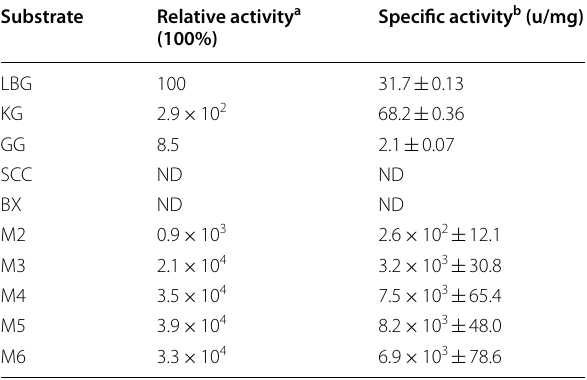
ND not detected a The relative activity of PcMan113 towards LBG was set as 100% b The specific activity of substrates by PcMan113 catalyzing in vitro. Reaction conditions: 5 mM substrate with 0.2 mg mL − 1 purified protein in 200 μL PBS– citric acid buffer (20 mM, pH 6.0) at 45 ℃ for 10 min